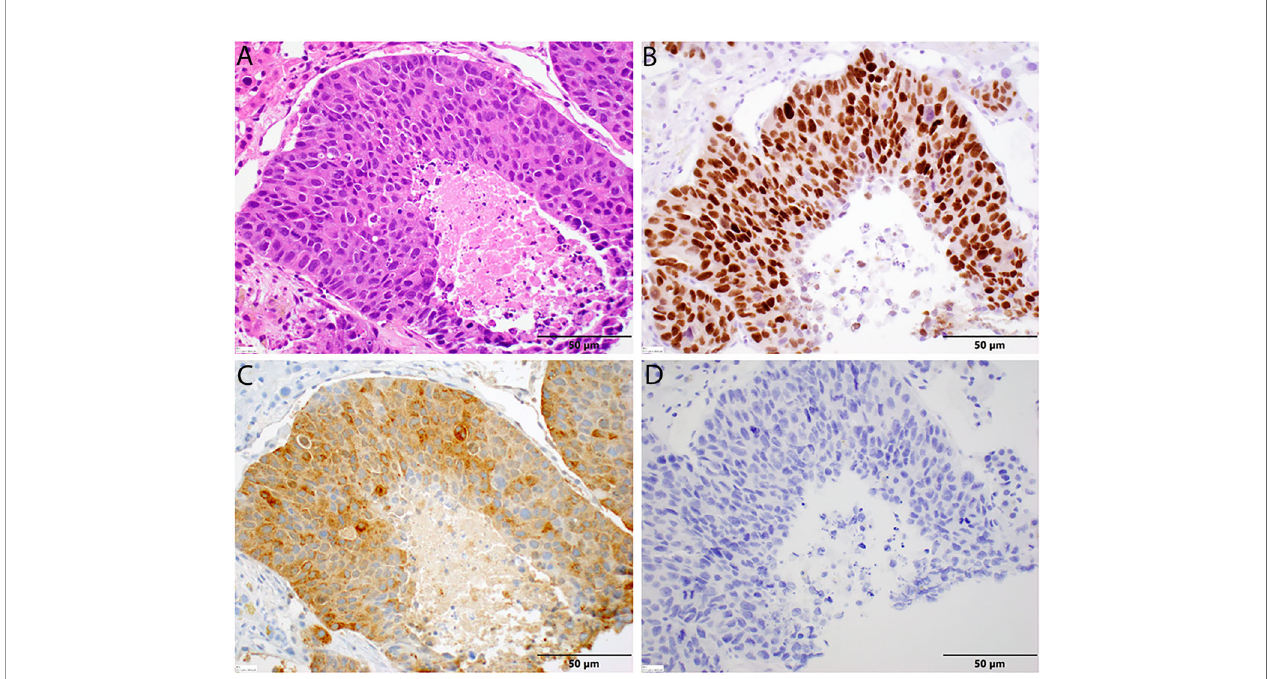
FIGURE 1 | Histopathology of liver biopsy. (A) Metastatic prostate adenocarcinoma displaying signi fi cant nuclear enlargement and pleomorphism, prominent nucleoli, mitotic fi gures, and comedo-type central necrosis in this representative fi eld. Note the absence in neuroendocrine features and the surrounding benign hepatocytes [H&E stain, 40× magni fi cation]. (B) Diffuse nuclear positivity with NKX3.1 in tumor cells [NKX3.1 stain, 40× magni fi cation]. (C) Diffuse cytoplasmic positivity with PSA in tumor cells. (D) No cytoplasmic staining with chromogranin in tumor cells [chromogranin, 40× magni fi cation].